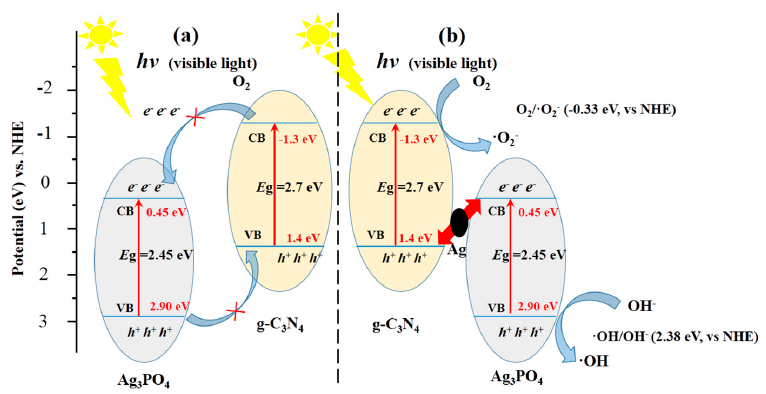
Figure 13. Schematic diagram of the photoexcited electron-hole transfer process ( a ) Double-transfer mechanism; and ( b ) Z-scheme